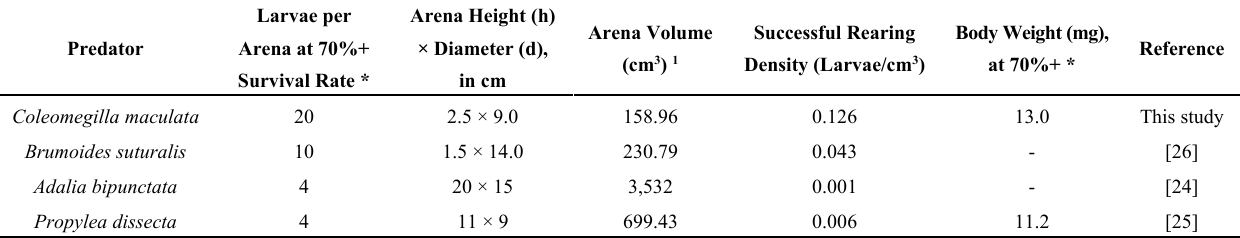
Table 2. Comparison of larval density ensuring a survival rate of 70% or greater, successful rearing density, and female body weight of ladybird beetles used in biological